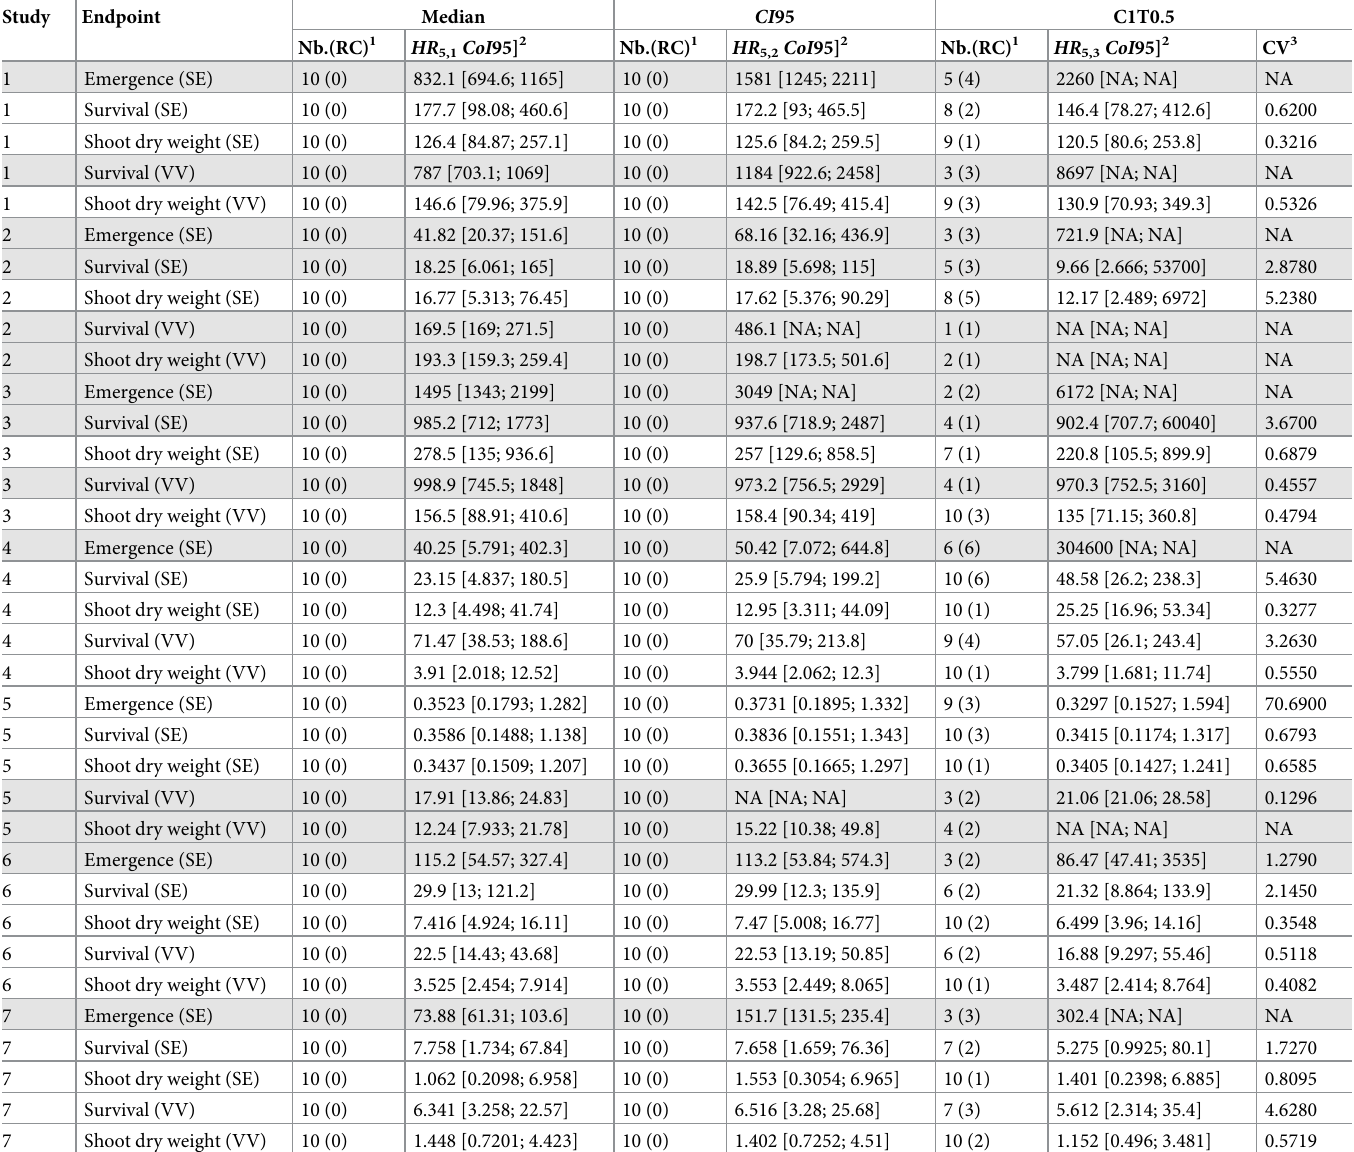
Table 3. Comparison of results on HR 5 based on different handling criteria for input ER 50